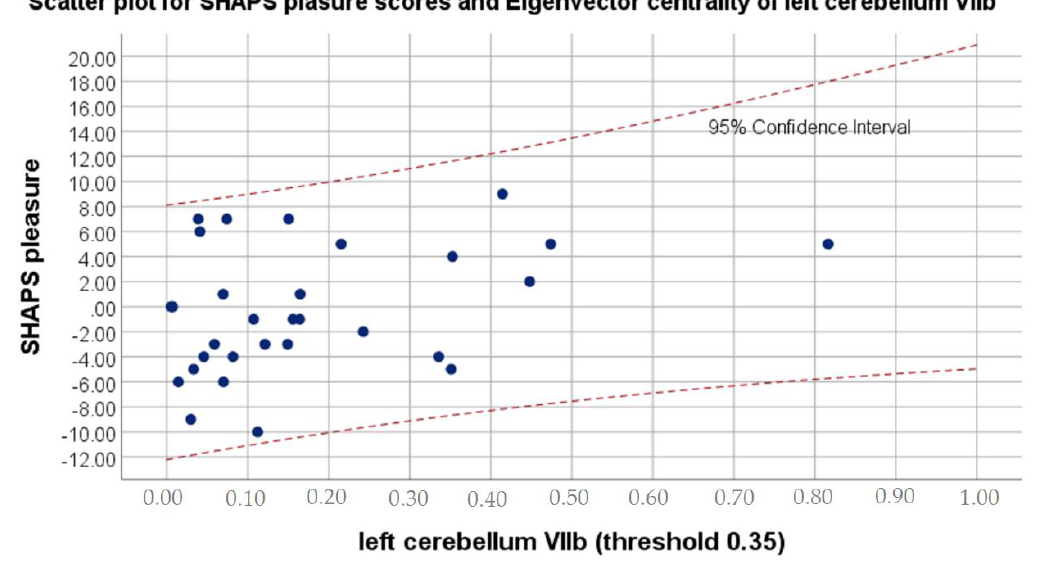
Figure 1. Scatter plot for SHAPS pleasure scores and Eigenvector centrality values on 0.35 threshold of left cerebellum